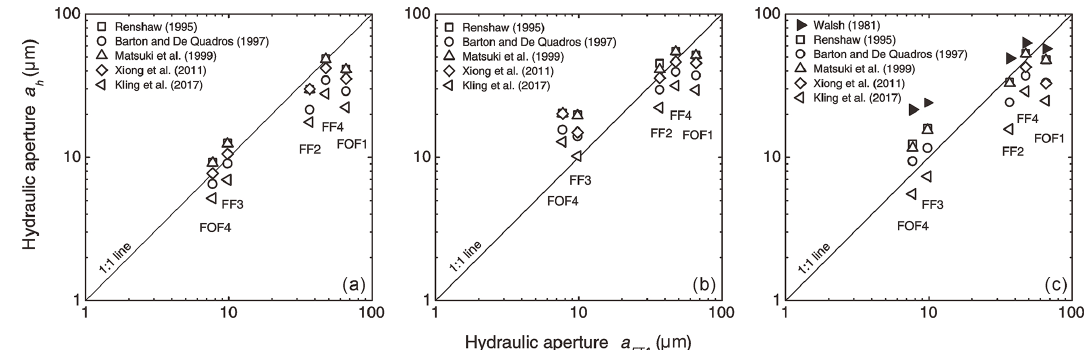
Figure 11. Cross-plots of calculated hydraulic apertures based on microscopic images of fracture profiles ( a h ) and hydraulic apertures a FTA measured with the flow-through apparatus (FTA). (a) Median and (b) mean hydraulic apertures a h using MC-based mechanical apertures of each image in combination with the equations listed in Table 1. (c) Hydraulic apertures a H derived from Eq. (7) (black triangles) and hydraulic apertures a h derived from the totality of measured mechanical apertures of each sample (see Fig. 8) are shown for